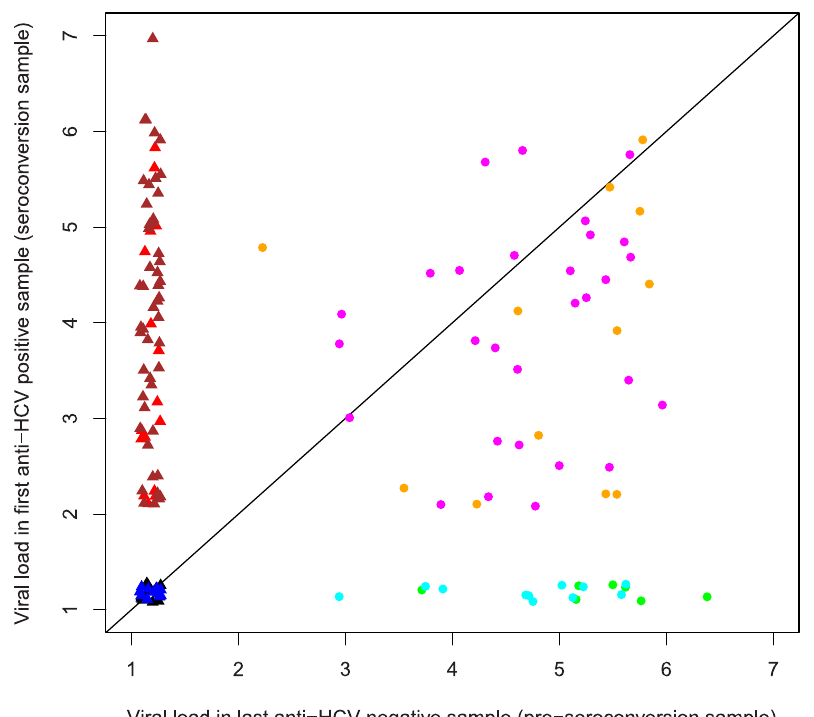
Figure 2. Pairwise comparison of individual viral loads in the pre-seroconversion versus seroconversion samples. Patients (n=61) with detectable viremia already in the pre-seroconversion sample are shown by circles, and those non-viremic (n=89) in the last anti-HCV negative by triangles, the latter group not yet showing any sign of being infected. Patients in each group A–H are displayed in the same colours as in figure 1(A=black, B=red, C=dark blue, D=brown, E=green, F=orange, G=cyan/light blue, H=magenta). Viral titres are shown in a log 10 scale, statistical analysis by exact binomial test. Statistical analysis was also done excluding group G (n=11, pattern + to 2 to + ), where re-emergence vs re- infection was difficult to establish. When the total cohort (n=150) was included, viral load was significantly lower or equal to in the pre- seroconversion sample (p , 0.001, CI 0.57–0.73) due to the majority still being non-viremic/non-infected. For the subgroup with pre-seroconversion viremia, viral load was instead significantly lower in the seroconversion sample than in the pre-seroconversion sample (p , 0.001, CI 0.74–0.93). Excluding group G, values remained similar for the whole cohort (now n=139, pre-seroconversion viral load lower than seroconversion viral load, p=0.003, CI 0.54–0.71) as well as for the subgroup viremic in the window phase (now n=50, seroconversion viral load lower than pre-seroconversion, p , 0.001, CI 0.69–0.91).